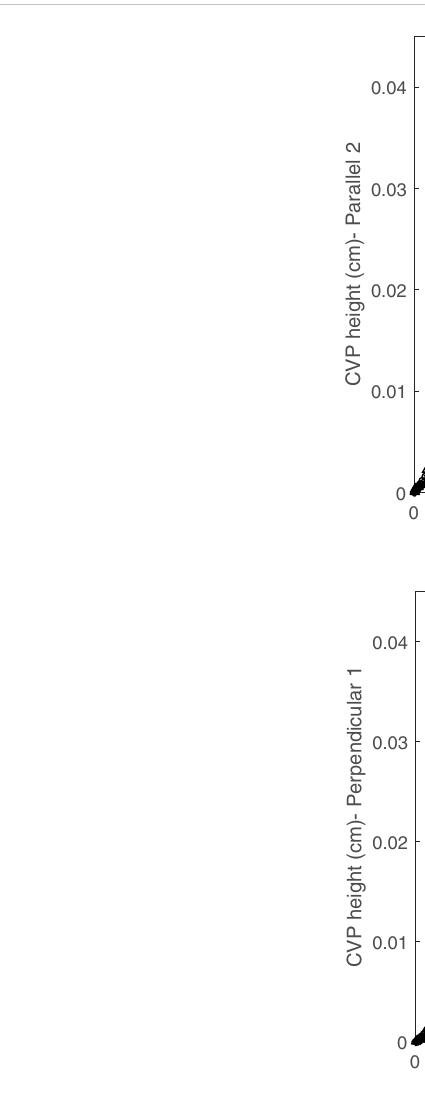
FIGURE 13 The Repeatability of CVP graphs obtained in three consequence days. Comparing scans collected (A) from the same directions of travel and (B) from the perpendicular directions of travel during three days (9, 10 and 11 of September 2020) from the same